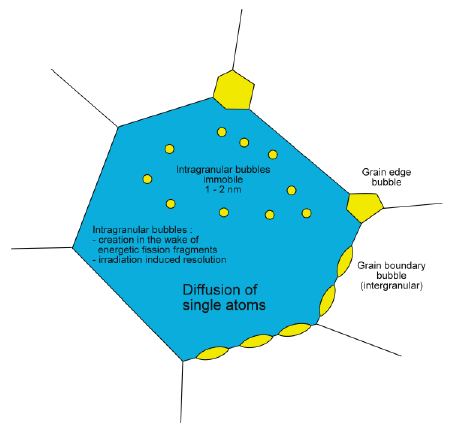
Figure 1. Basic mechanisms of fission gas release